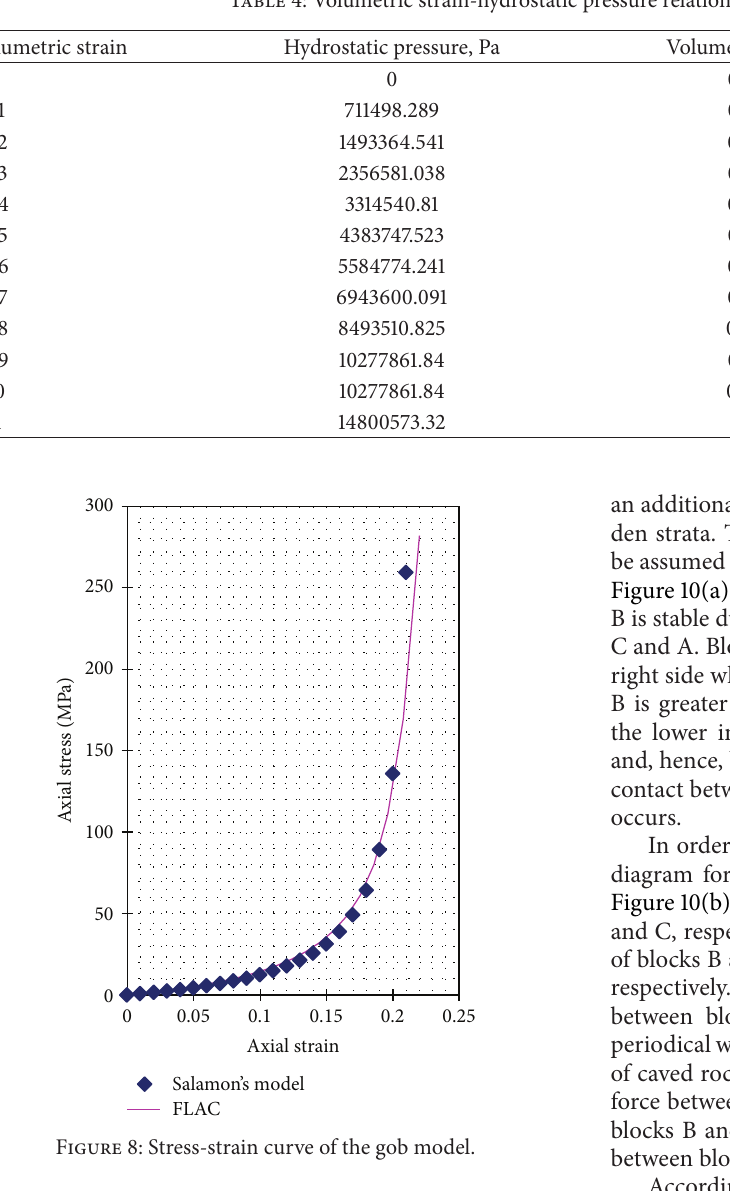
Table 4: Volumetric strain-hydrostatic pressure relationship of the gob material.